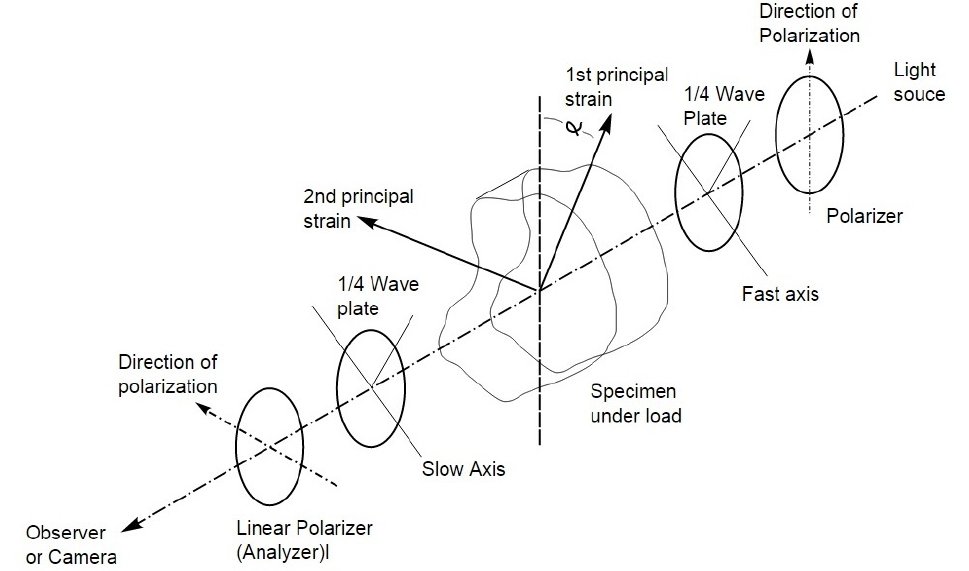
Figure 1. Schematic representation of a circular